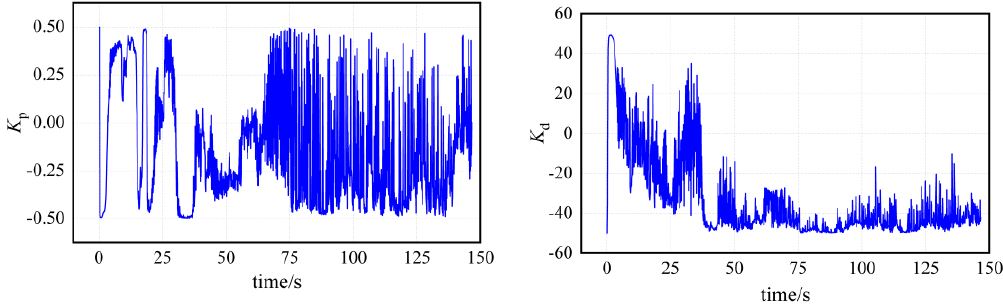
Figure 14. 𝐾 p , 𝐾 d curves. Figure 14. K p , K d curves.